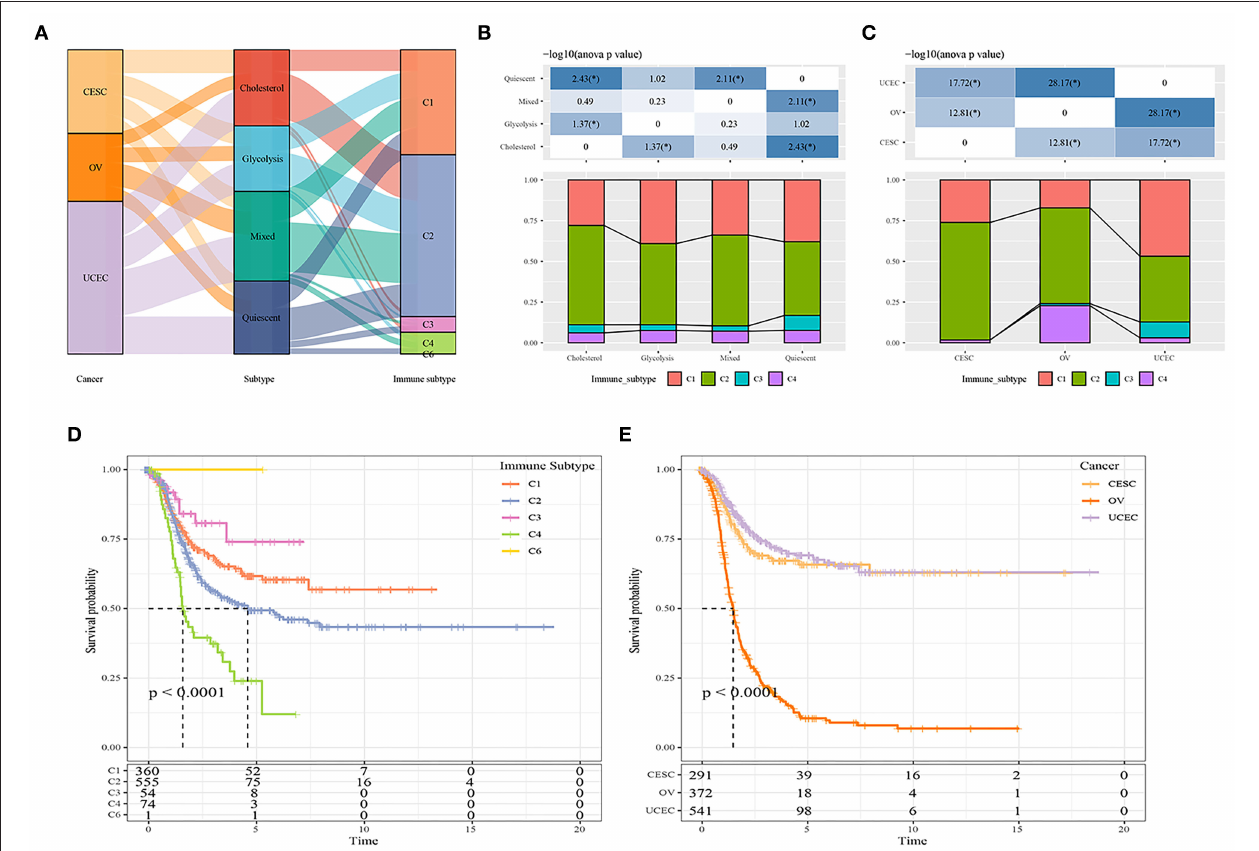
FIGURE 3 | (A) Comparison between metabolic subtypes and existing subtypes; (B) Comparison of distribution of immune subtypes among different metabolic subtypes; (C) Comparison of distribution of immune subtypes among different cancer types. (D) The prognostic difference of metabolic molecular subtypes in C1-C6 immune subtypes. (E) The prognostic difference of metabolic molecular subtypes in OV, UCEC, CESC tumor types.